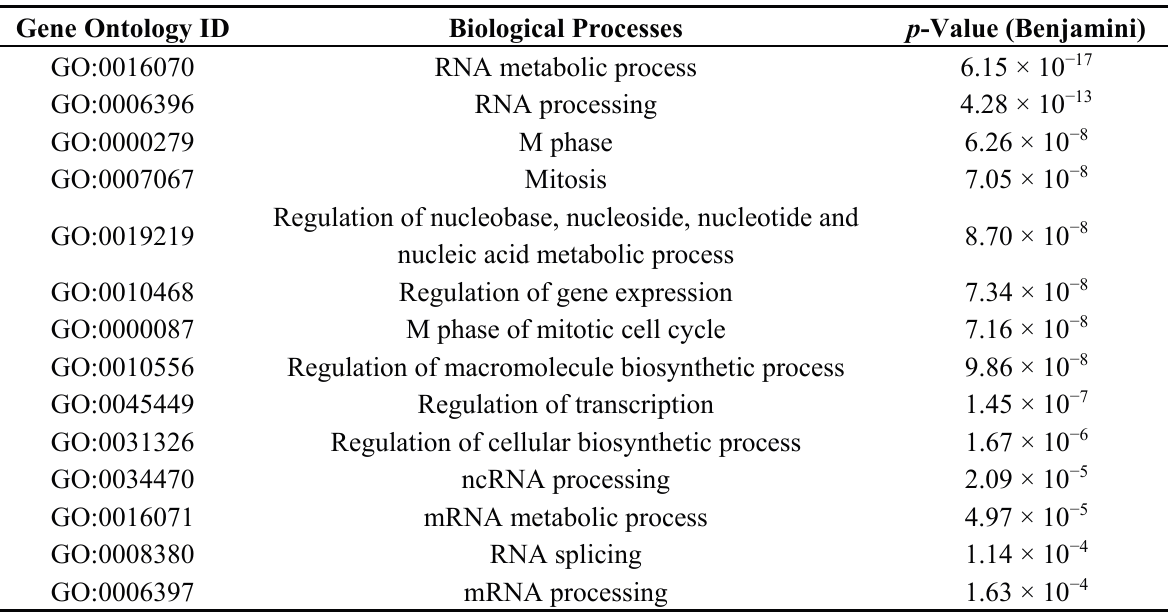
Table 3. Gene ontology analysis for 1236 probes selected from ADE-treated TK6 cells. Gene Ontology